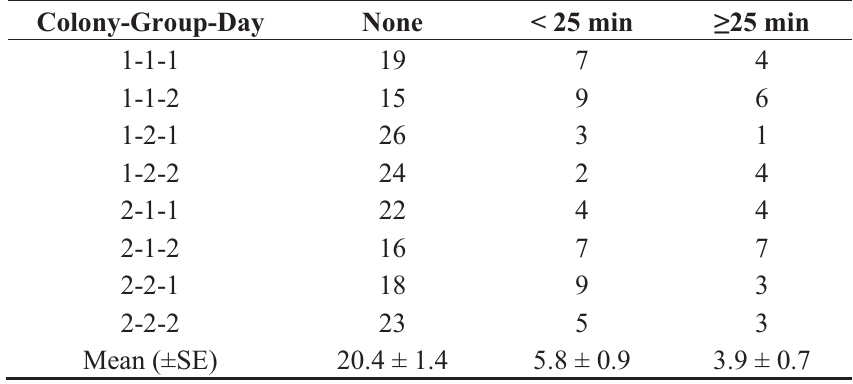
Table 2. Number of termites in three categories of time spent tunneling (none, < 25 min, ≥25 min) in each 1-h tunneling trial conducted on consecutive days with the same group of 30 workers with two groups from each